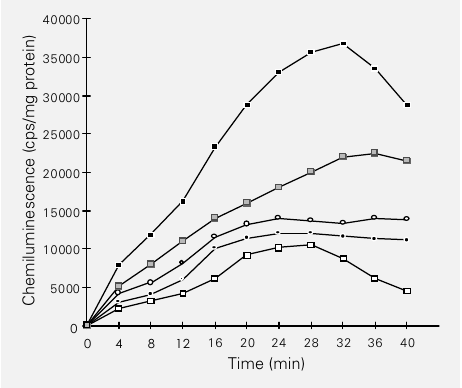
Figure 1 - Effect of a methanolic extract of P. peltata on the time course of hydroperoxide-initi- ated chemiluminescence in rat liver homogenates. “ , No addi- tion; @ , 1000 (cid:181)g/ml; ` , 100 (cid:181)g/ ml; ! , 10 (cid:181)g/ml, and , 1 (cid:181)g/ml. Zero time was the moment of tert -butyl hydroperoxide addi- tion. Values reported are the mean of 2 determinations.